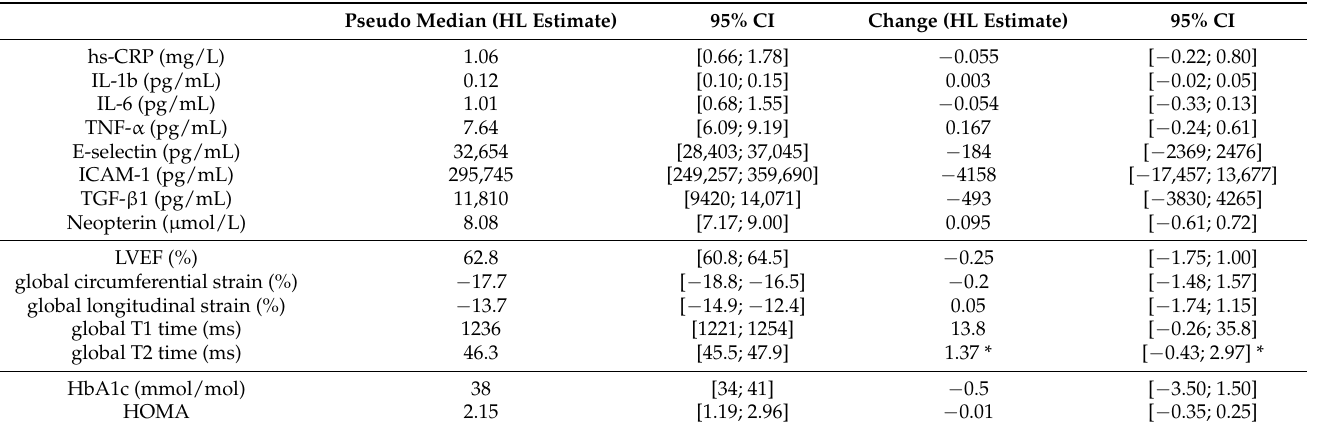
Table 3. Baseline parameters and changes in inflammatory markers, myocardial function, tissue mapping, and glucose metabolism after 12 weeks of treatment with bulevirtide (5 mg/d; n = 13, per-protocol population). HL: Hodges–Lehmann, CI: Confidence interval.